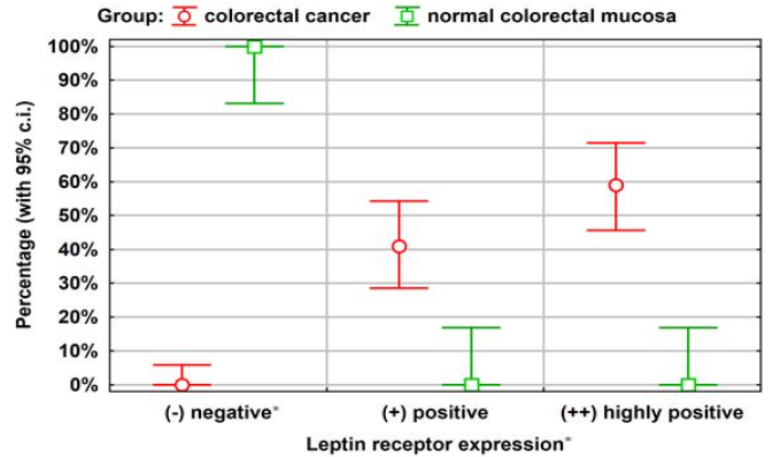
Figure 1. Leptin receptor expression among patients in the study group ( n = 61) and comparison group ( n = 20). Statistical analysis was performed using the Kruskal-Wallis test and the Mann-Whitney test; * p = 0.001, CI (confidence interval) was calculated by Student’s t -test. Among the cancerous tissues, all of the 61 (100%) samples were stained positive or